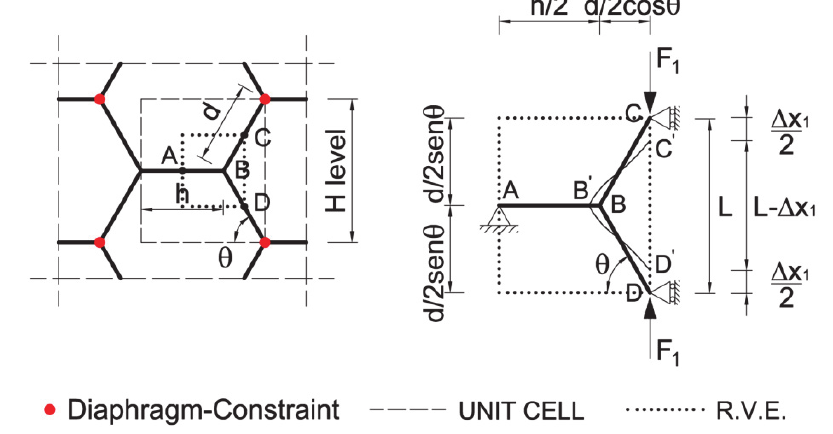
Figure 13: Hexagrid axial test along x 1 : modified RVE accounting for the RD